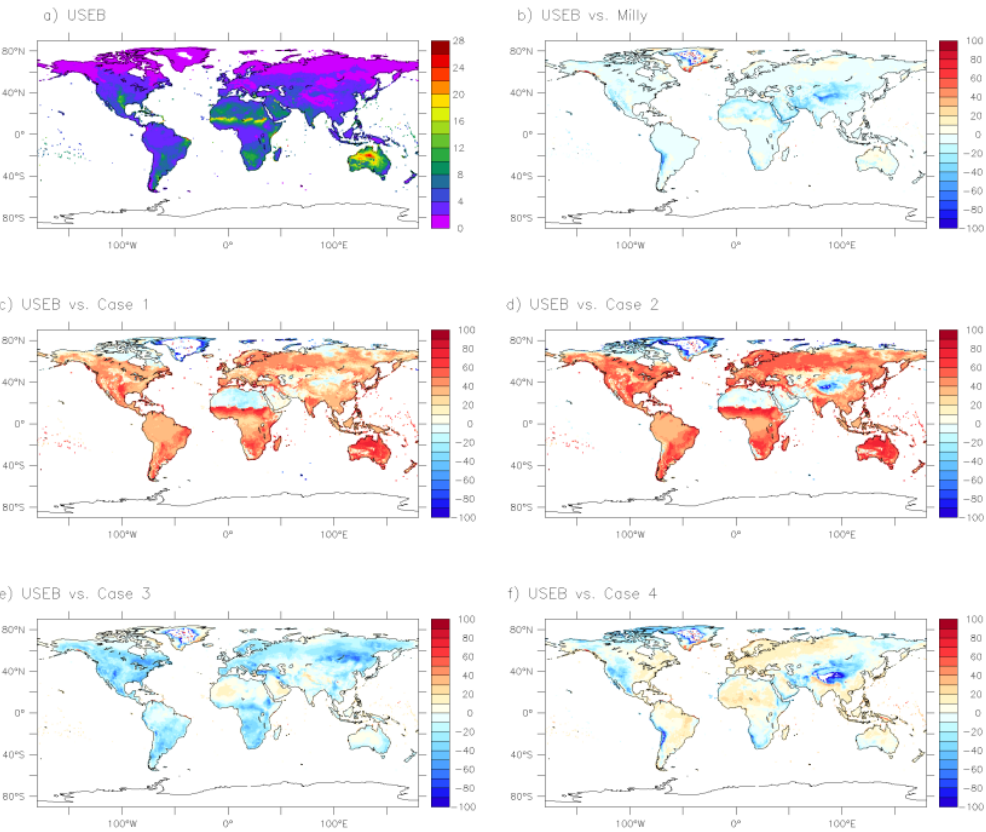
Fig. 1. The USEB method’s ET P mean annual values (mmd − 1 ) for the reference period (a) . Differences, given in %, between the USEB and Milly methods (b) , as well as between the USEB method and the first four cases defined for FAO’s equation ( c to f ). Whereas red colours provide higher values dealing the USEB method, blue ones imply that FAO’s reference equation or Milly’s method provide higher ET P